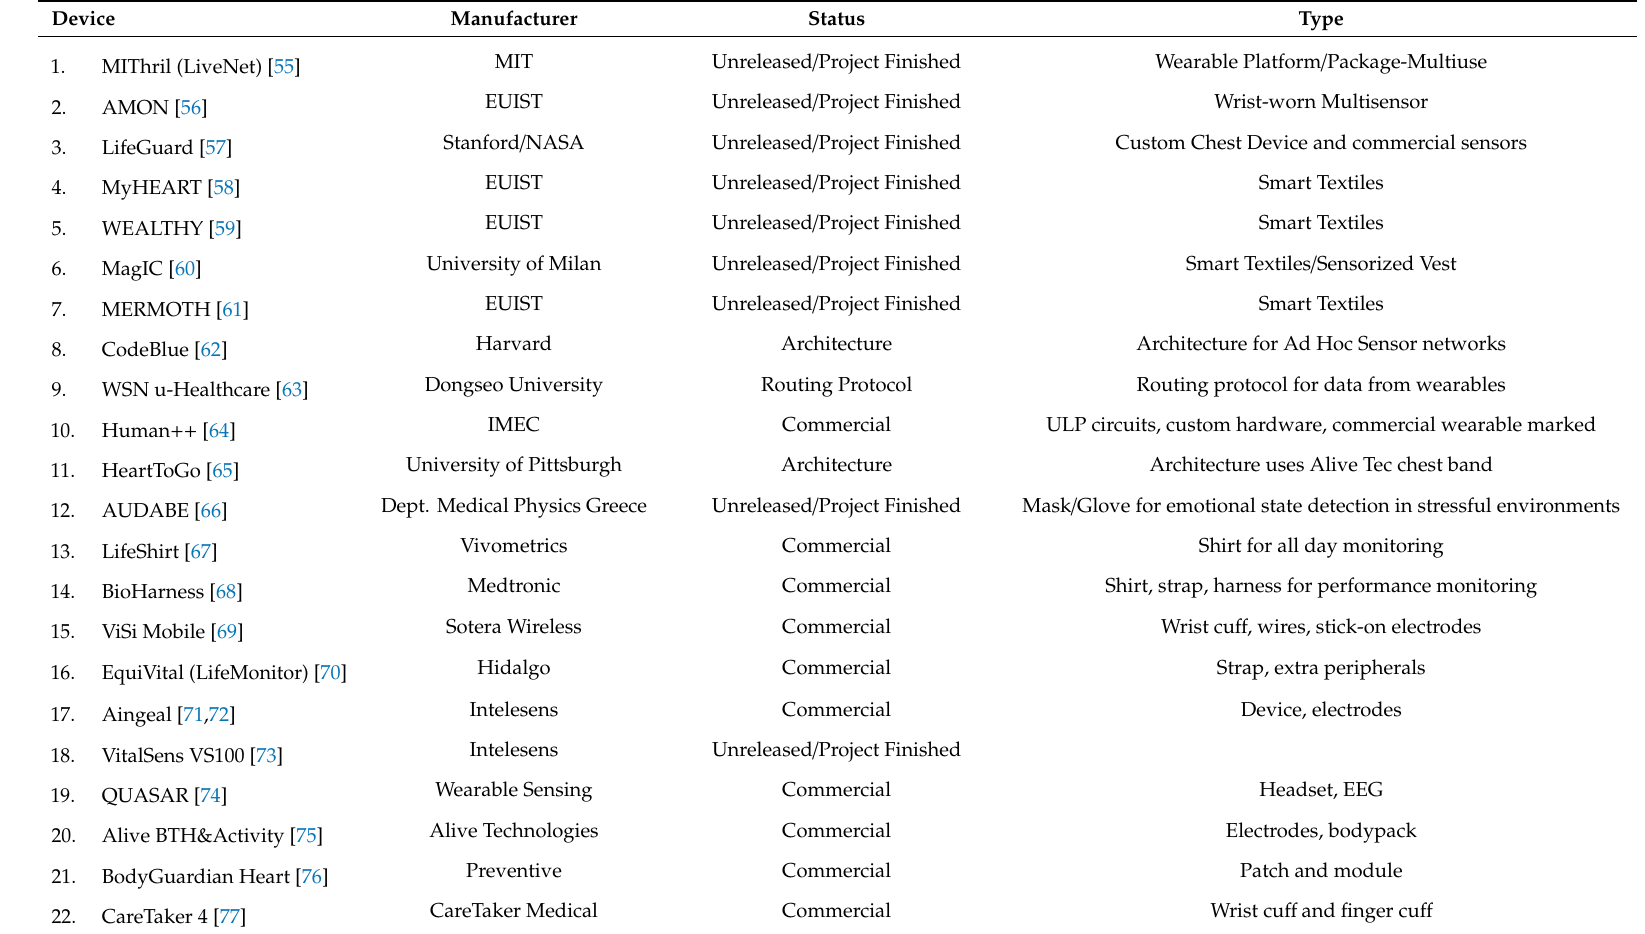
Table 1. Summary of wearable